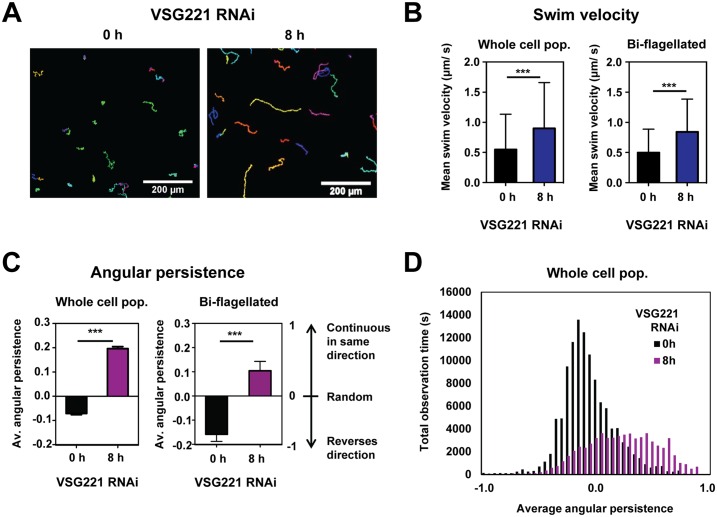
Motility analyses show an increase in swim velocity in cells where VSG synthesis has been inhibited.
(A)
T. brucei swims more persistently in the same direction after VSG synthesis is blocked. Particle motion tracks of cells where VSG221 RNAi was induced for 0 or 8 hours (h). Each track represents the distance travelled by an individual cell over the course of measurement. One image was captured every 200 ms (5 Hz) for 1.7 minutes. Scale bar: 200 μm. (B) There is a significant increase in swim velocity (or directional swimming) after the induction of a VSG synthesis block for 8 hours. Velocity is shown in μm per second (s). The whole population (2500 cells) is compared with 50 bi-flagellated cells from the induced or uninduced population. Statistical significance was determined with Student’s t-test (***P<0.0001). (C) Increase in angular persistence in cells where VSG synthesis has been blocked. The average (av.) angular persistence is shown in either the whole cell population or bi-flagellated cells. Angular persistence is denoted on an arbitrary continuous scale of -1 to 1 where a value of 1 indicates continuous swimming in the same direction as observed after a 2 second period, a value of 0 represents cells moving in a random direction after this time period, and a value of -1 represents a trypanosome observed swimming in the reverse direction after 2 seconds. 1500 cells from the whole population (pop.) and 50 bi-flagellated cells are analysed. The observed change in motility after the induction of a VSG synthesis block was highly significant (***P<0.0001). (D) Histogram distribution showing an increase in persistent directional swimming in cells where VSG synthesis was blocked. The data is from 1500 cells from the whole population (either untreated or where VSG221 RNAi has been induced for 8 hours) which are also analysed in panel (C).